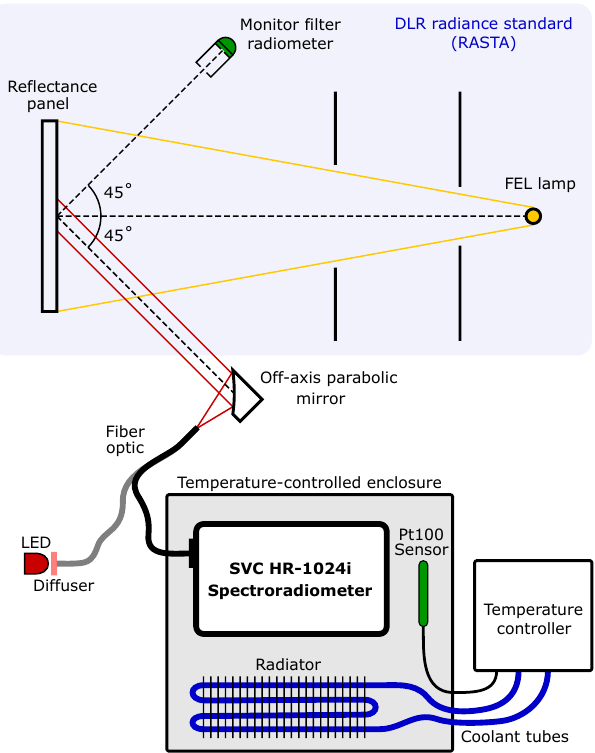
Figure 1. Radiometric response calibration setup of the spectroradiometer on the DLR radiance standard (RASTA). The calibrated radiance from a reflectance panel illuminated by an FEL lamp is monitored by five filter radiometers, but only one radiometer is shown in the sketch for clar- ity. The spectroradiometer is calibrated inside a temperature-controlled enclosure where the air temperature is maintained by a radiator and monitored by a Pt100 temperature sensor connected to a temperature-controller. The fiber optic bundle from the spectroradiometer is attached to an off-axis parabolic mirror that reduces the spectroradiometer’s field of view to approximately 4°. The spectroradiometer’s field of view is aligned to the center of the RASTA reflectance panel with the off-axis parabolic mirror. This is aligned before the radiometric calibration by coupling the light from a diffused LED source into the fiber optic instead of the